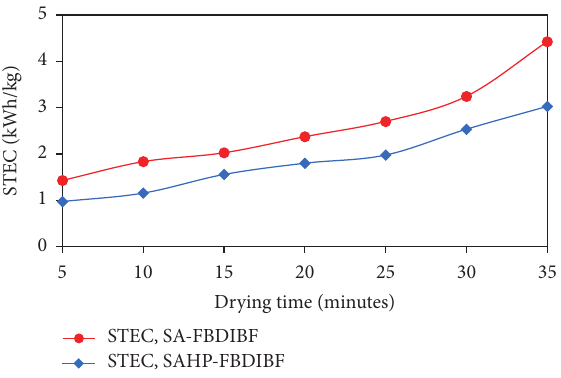
Figure 16: The variation of moisture content with drying time.